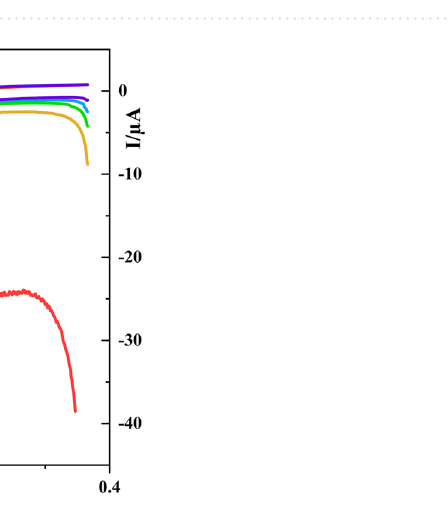
Figure 2. Multi-cyclic voltammogram of 0.4 M 4-carboxyphenyl diazonium salt at the surface of GCE in acetonitrile solution containing 0.1 M LiClO4, scan rate: 100